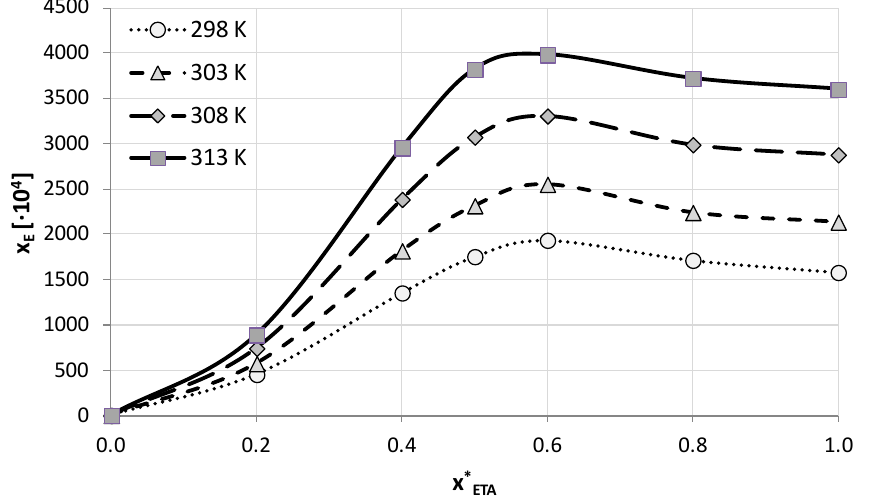
Figure 2. Mole fraction solubility of edaravone in mixtures of water and ETA (ChCl:EG = 1:2 molar ratio). On the abscissa, x* ETA represents the mole fractions of ETA in solute-free solutions. Detailed results are available in Table S2 in Supplementary Materials.